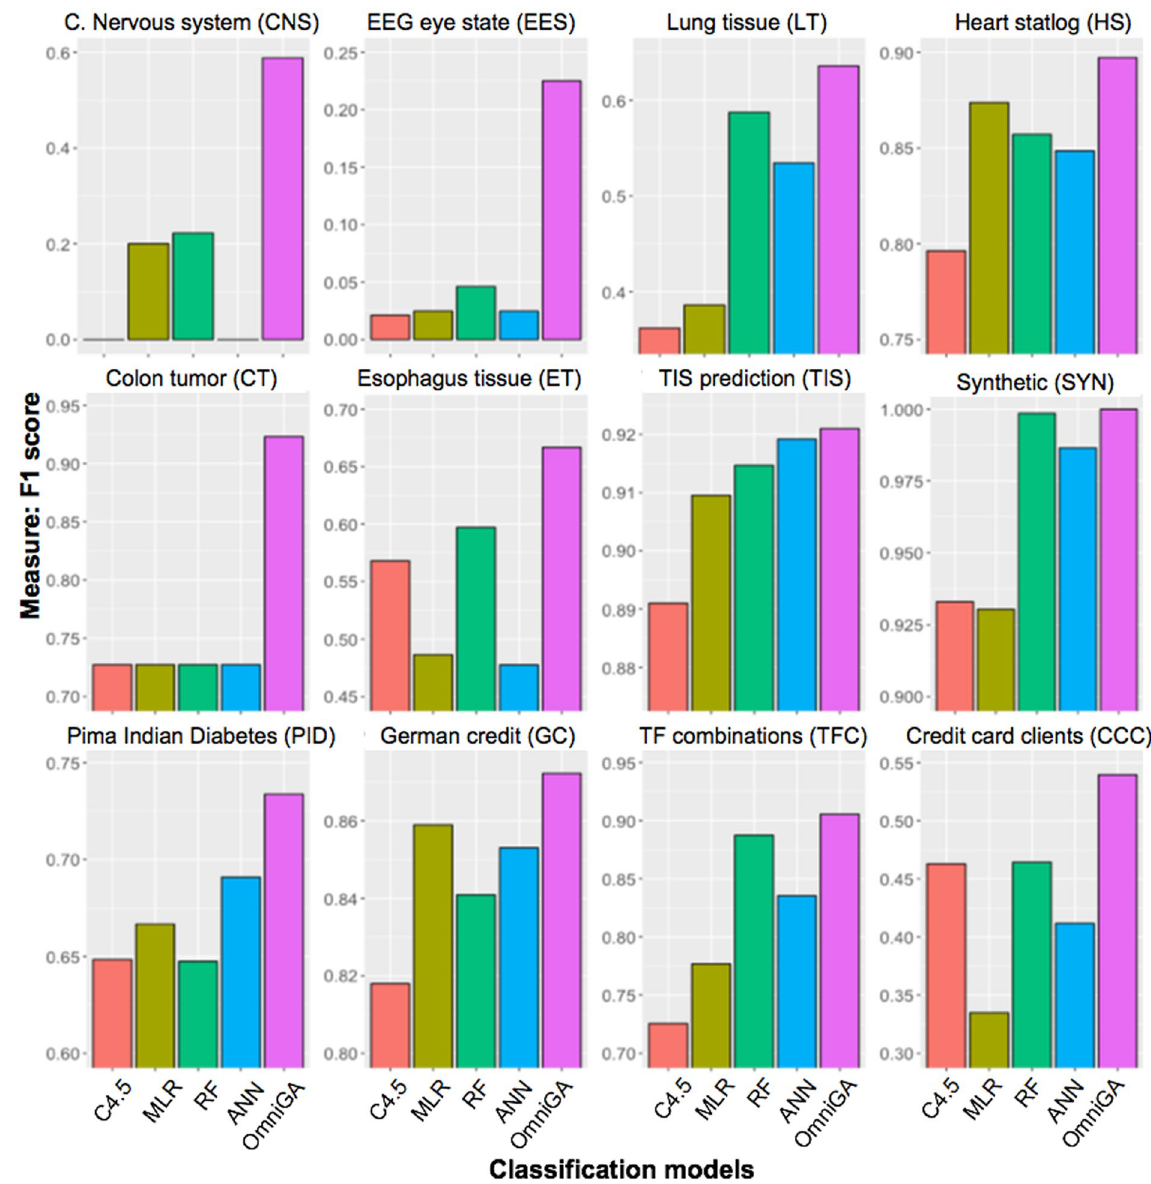
Figure 2. Models performance. F 1 for each model on the twelve considered